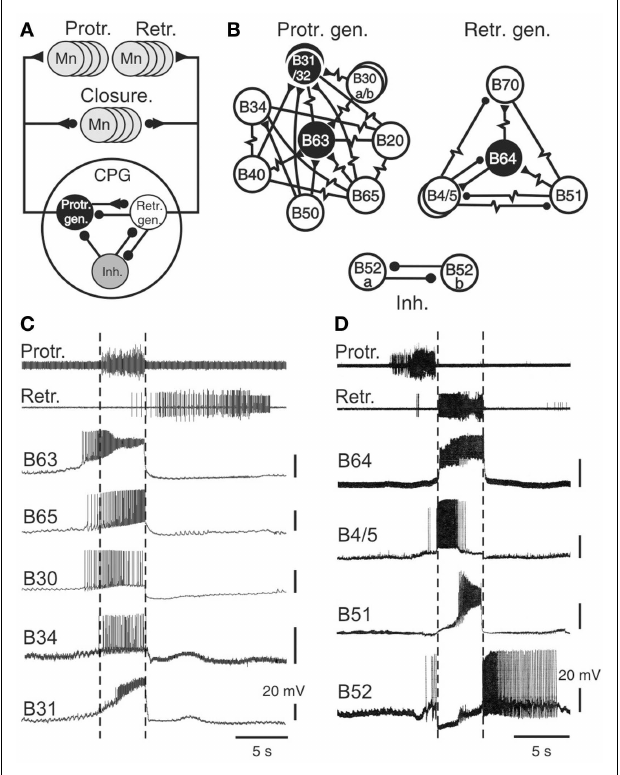
FIGURE 3 |The radula motor pattern generating network. (A) Simplified schematic of the buccal central pattern generator (CPG) and its synaptic connections with protractor, retractor, and closure motor neurons (Mn); the small filled circles represent inhibitory connections while triangles denote excitatory connections.The CPG is composed of three distinct and interconnected groups of neurons: a protractor generator (Prot. gen.), retractor generator (Retr. gen.), and a group of inhibitory neurons (Inh.). (B) Detailed schematics showing the neuronal diversity and synaptic connectivity within the protractor and retractor generators, and the inhibitory group. Neurons that are necessary and sufficient for radula motor pattern genesis are in black (see text). Simple resistor symbols represent non-rectifying electrical coupling; resistor symbols associated with a circle or triangle represent non-rectifying electrical coupling associated with an excitatory or inhibitory chemical synapse, respectively. For simplification, not all known synaptic connections including those between the different neuronal groups of neurons [see (A) ] are shown. (C) Simultaneous extracellular recordings of radula protraction and retraction motor output and intracellular recordings from neurons of the protractor generator.The B34 and B31 cells were recorded in a different preparation from the other protractor neurons, but during a motor pattern of similar protractor phase duration. Note that the burst onsets of B63, B65, and B30 anticipate protractor motor nerve activity (indicated by vertical dotted lines). (D) Simultaneous extracellular recordings of protraction/retraction motor output and intracellular recordings of retractor generator neurons (B64, B4, B51) and an inhibitory neuron